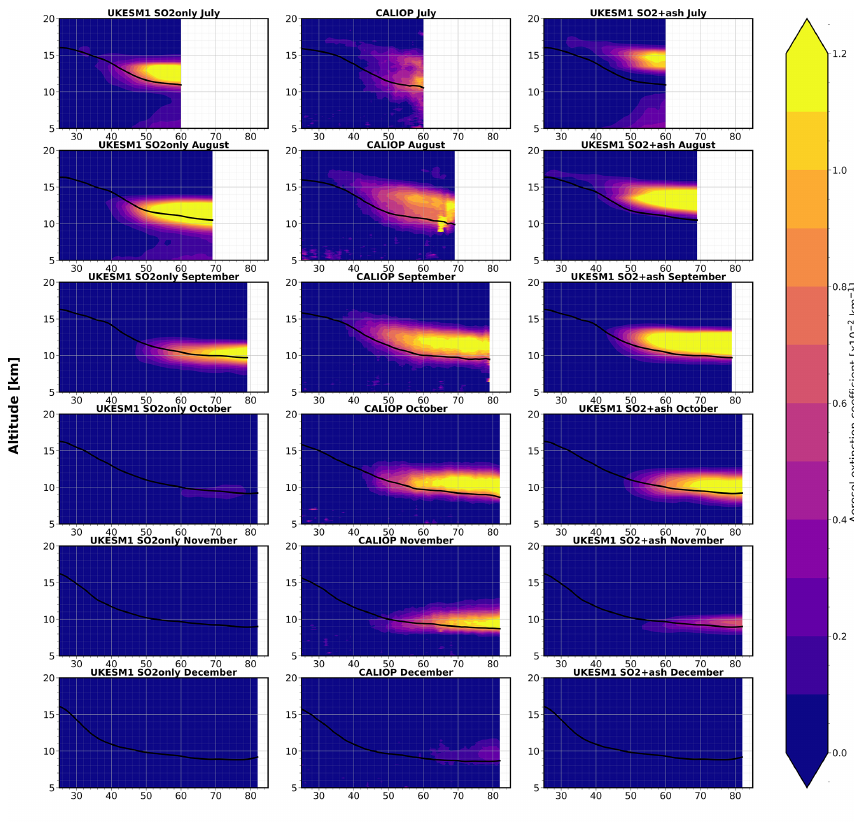
Figure 10. Aerosol extinction coefficient vertical profile averaged longitudinally. Averaged monthly CALIOP (centre) aerosol extinction coefficient vertical profiles (night retrievals only) with monthly average tropopause height (solid black). UKESM1 SO2only (left) and SO2 + ash (right) simulations with imposed CALIOP minimum retrieval limits and